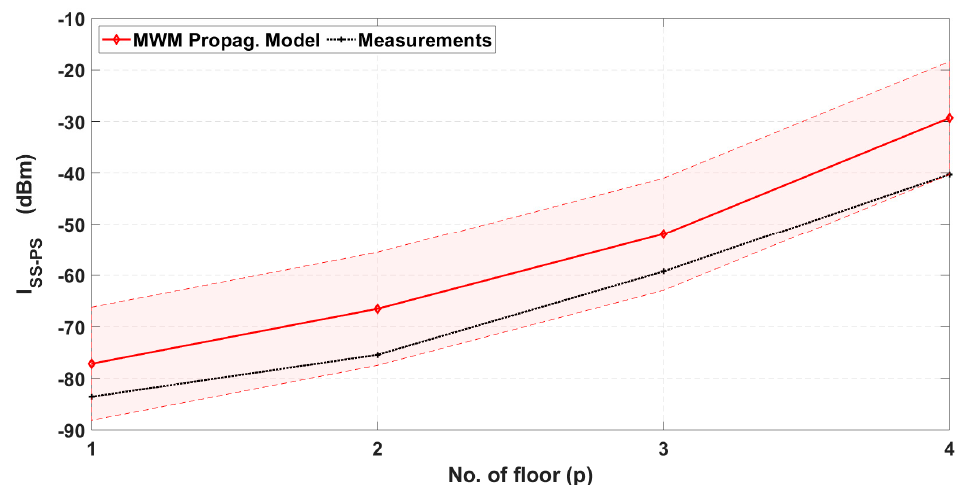
Figure 10. Comparison of power of simulated interference levels using Multi-Wall Model (MWM) and power measurements made on the rooftop of the small building, including the bounds of CI = 95%.